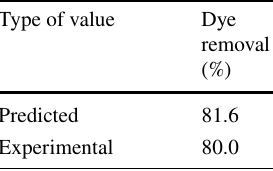
experimental values for the responses at optimum